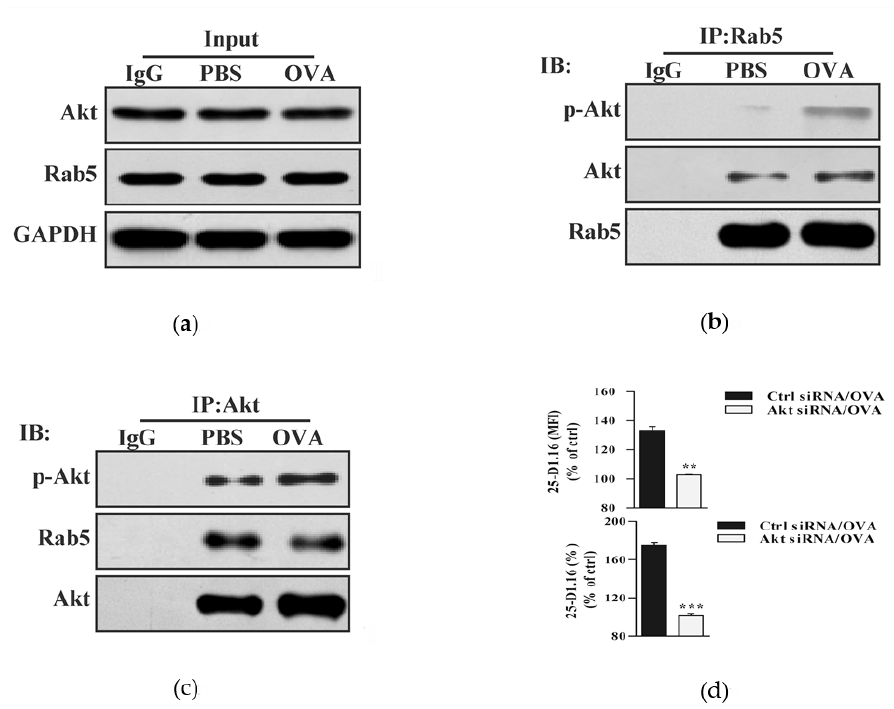
Figure 2. Akt phosphorylation is essential for endotoxin-containing